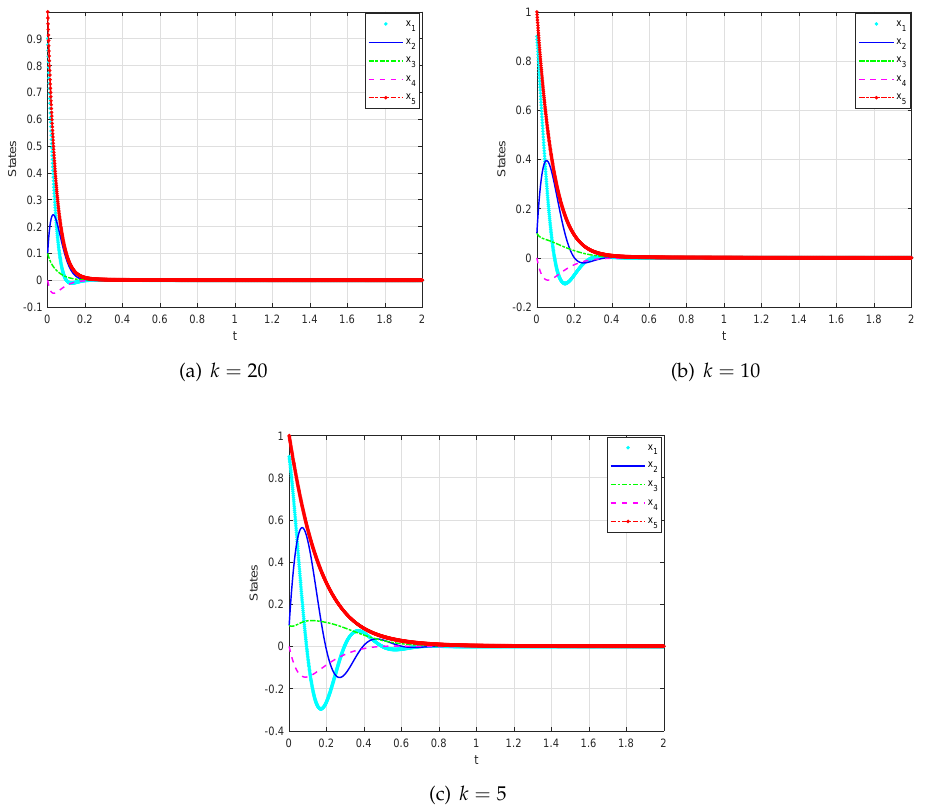
Figure 10. State trajectories of the controlled system (23) with α = 0.98, k = 20,10 and 5.